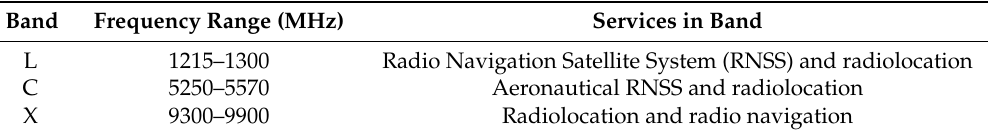
Table 1. Active EESS primary allocations in L, C and X bands.